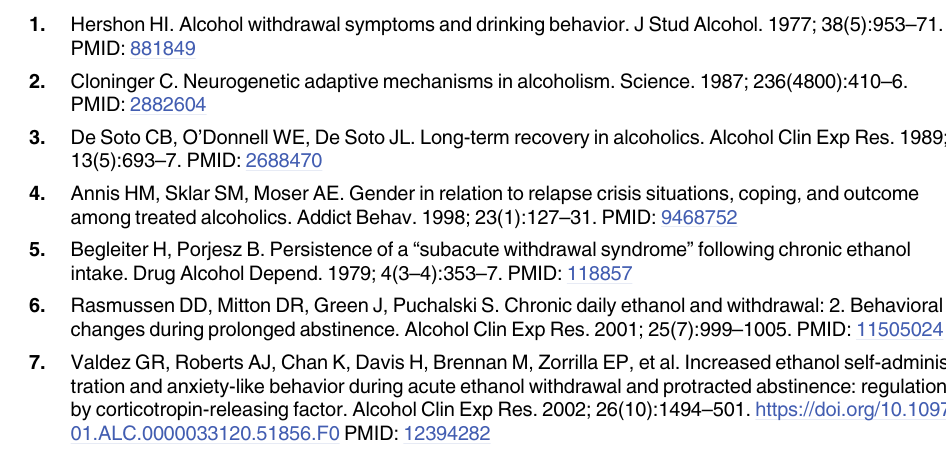
S2 Table. Time immobile data in the forced-swim test. S3 Table. Somatic withdrawal observation data. S4 Table. Summary and analysis of somatic withdrawal observation scores. Rats (n = 40) were maintained on an ethanol or control liquid diet for 28–30 days as described in the Meth- ods. To confirm physical ethanol dependence, rats were rated for somatic withdrawal signs. 24 hours after removal of the diets, rats were placed individually in a Plexiglas cage with a bed of wood shavings for 5 minutes. Sessions were video recorded and rats were rated by trained observers for the presence of a ventromedial distal limb flexation response, tail stiffness, and abnormal body posture. Each sign was rated on a 0 (absent) to 2 (severe) scale. Rats fed an eth- anol liquid diet had significantly higher somatic withdrawal signs compared to controls (t(38) = 4.74, p <